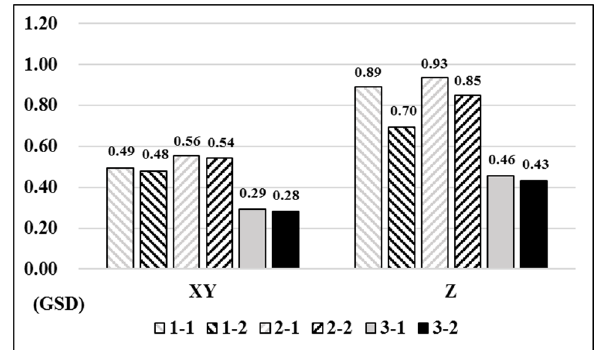
Figure 8. External accuracy of all test cases